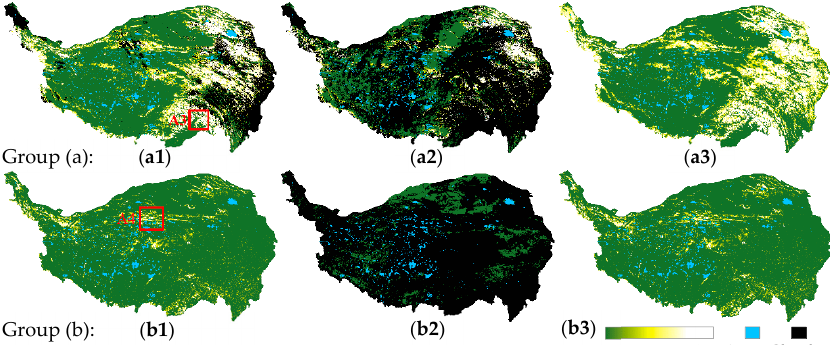
Figure 7. Validation results for 24 March 2016 (group (a)) and 10 September 2017 (group (b)). ( a1 , b1 ) “Ground truth”. ( a2 , b2 ) “Observed data”. ( a3 , b3 ) The cloud-removed results.